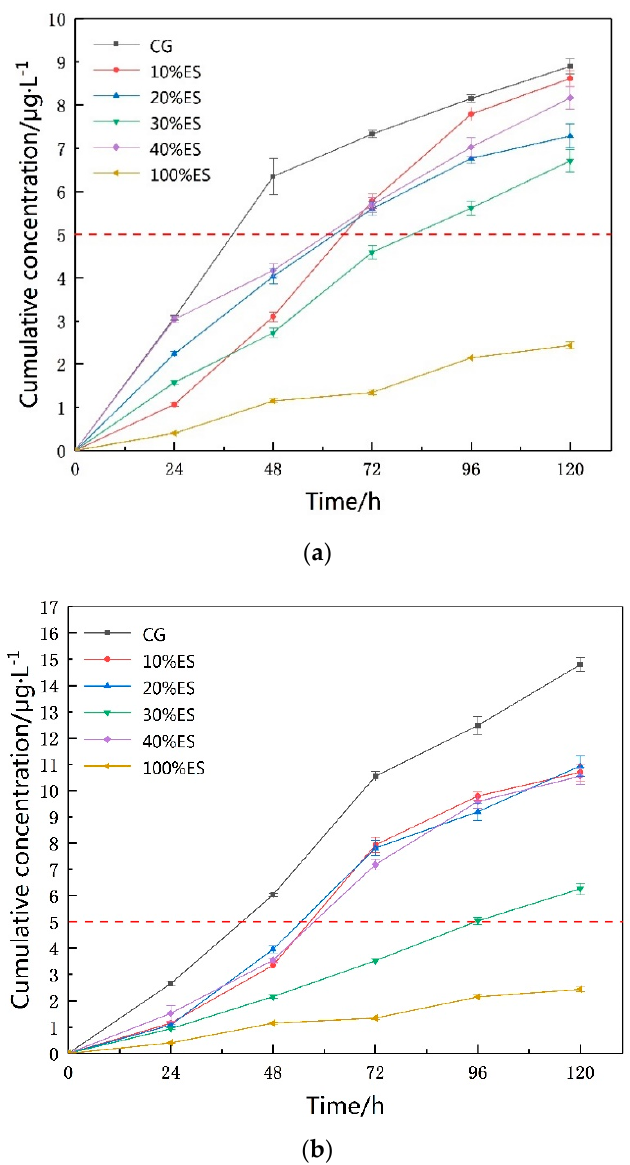
Figure 5. Leached cumulative concentration of Cr. ( a ) Concentration for DS-CG; ( b ) concentration for WH-CG.